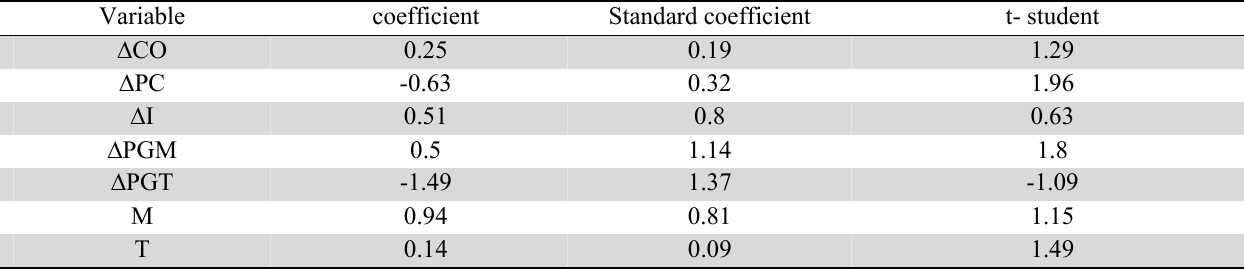
The summary of short term effect